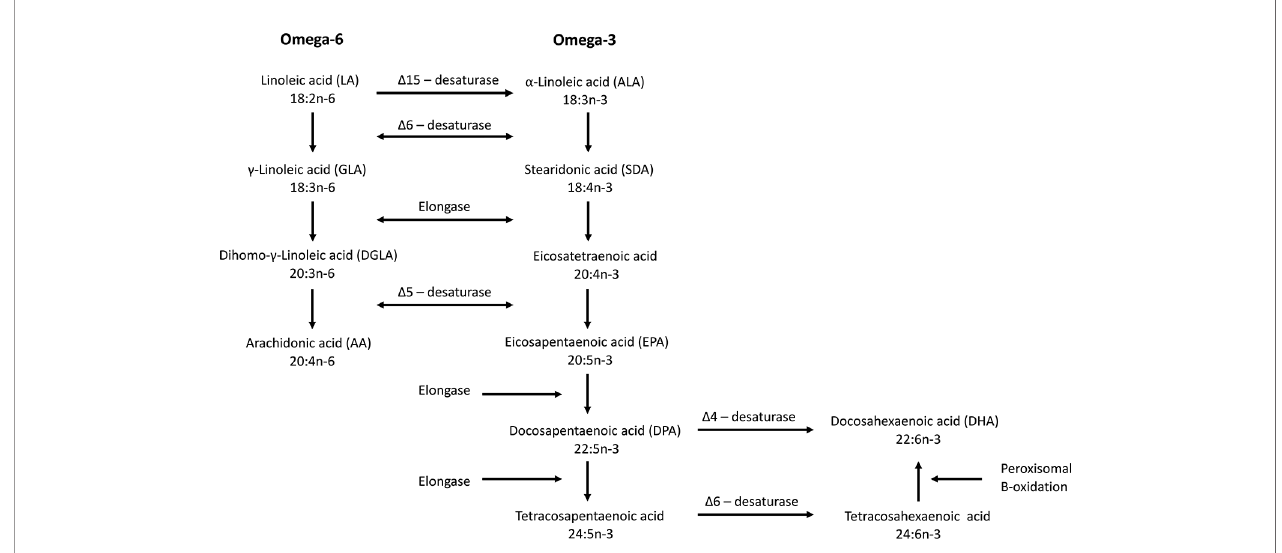
FIGURE 2 | Biosynthesis of omega-6 and omega-3 fatty acids. D -15 desaturase is only found in plants. D -4 desaturase is present in some vertebrates but not in humans. The D -6 desaturase catalyze is the rate limiting step in the synthesis of EPA and DHA (modi fi ed from Calder,